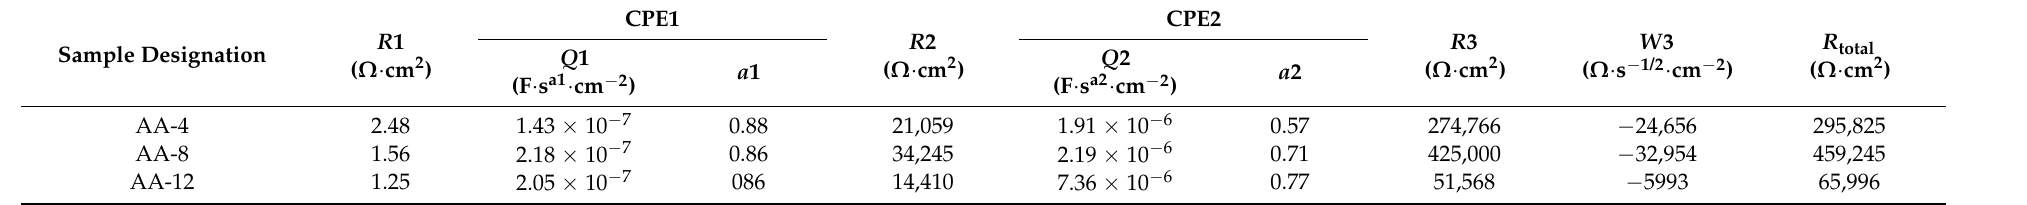
Table 4. The values of the equivalent circuit elements for investigated PEO-coated